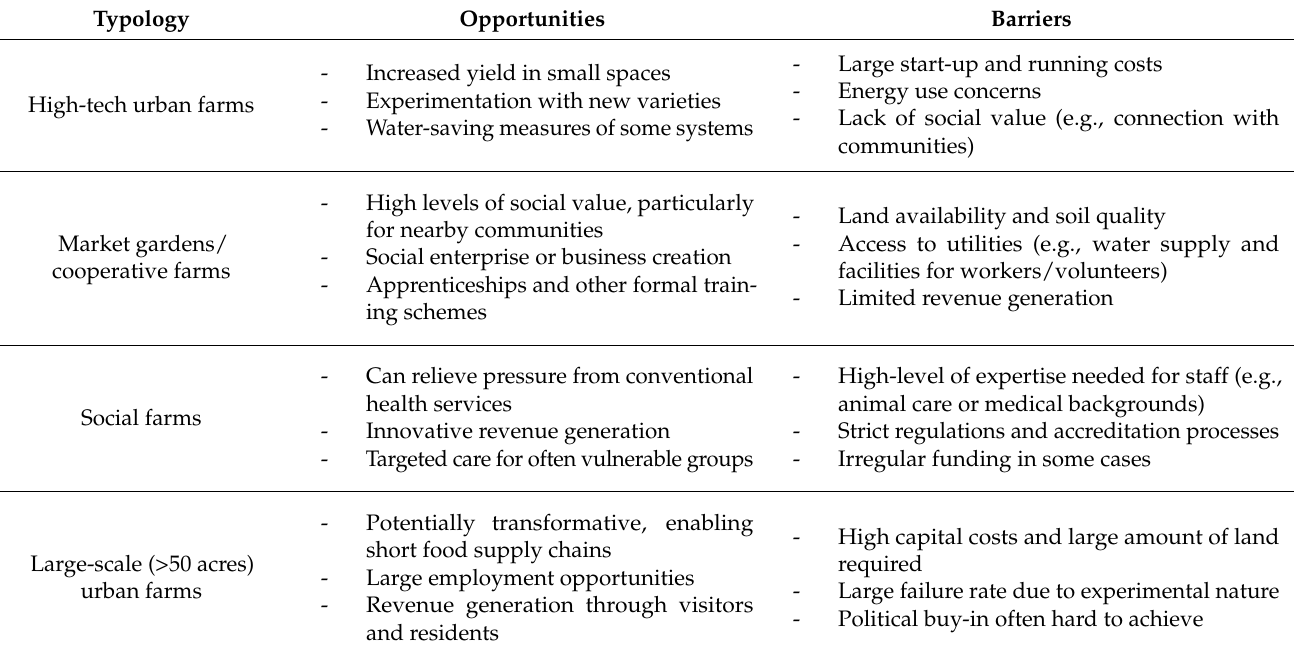
Table 2. Core opportunities and barriers of different forms of urban